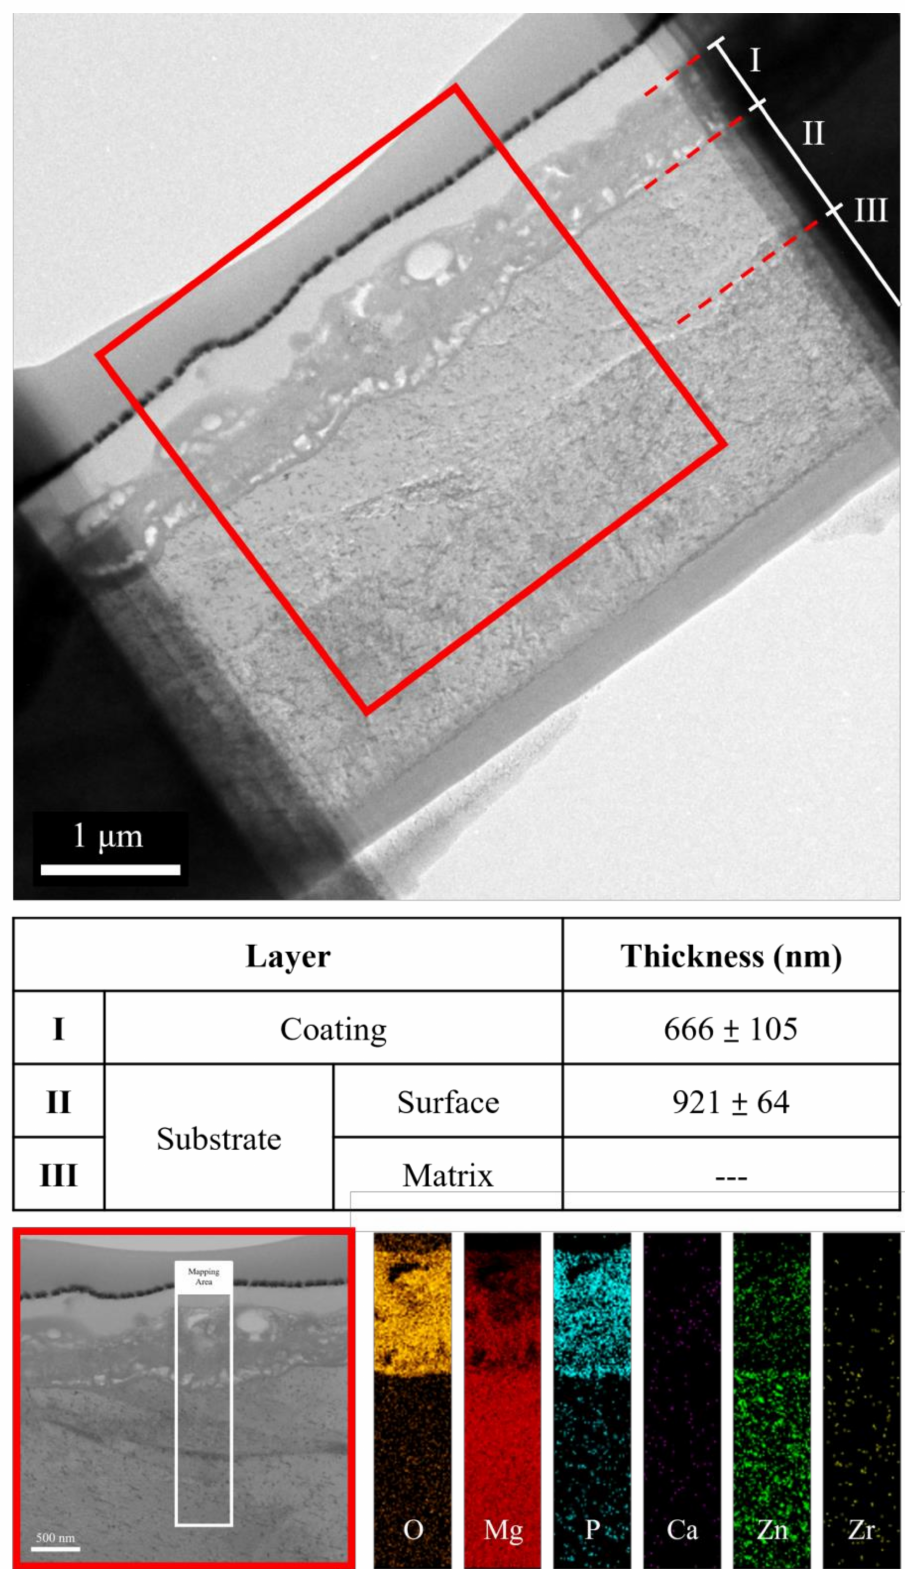
Figure 6. TEM image and EDS mapping of the anodic coating